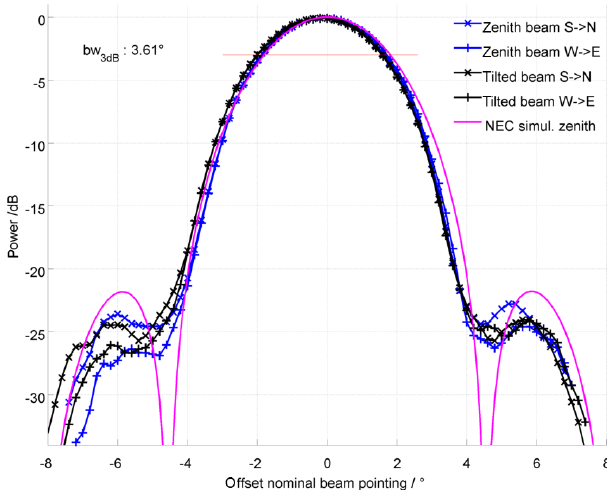
Figure 4. Cross sections through the angular occurrence rate for both beam-pointing directions, φ = 0 ◦ , θ = 0 ◦ (blue) and φ = 185 ◦ , θ = 12 . 4 ◦ (black) with respect to their nominal position, compared to the simulated radiation pattern